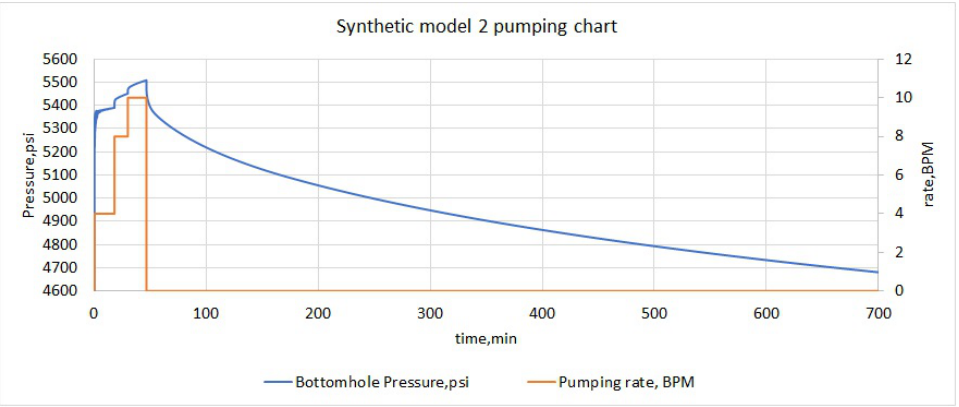
Figure 12. Synthetic model 2 pumping